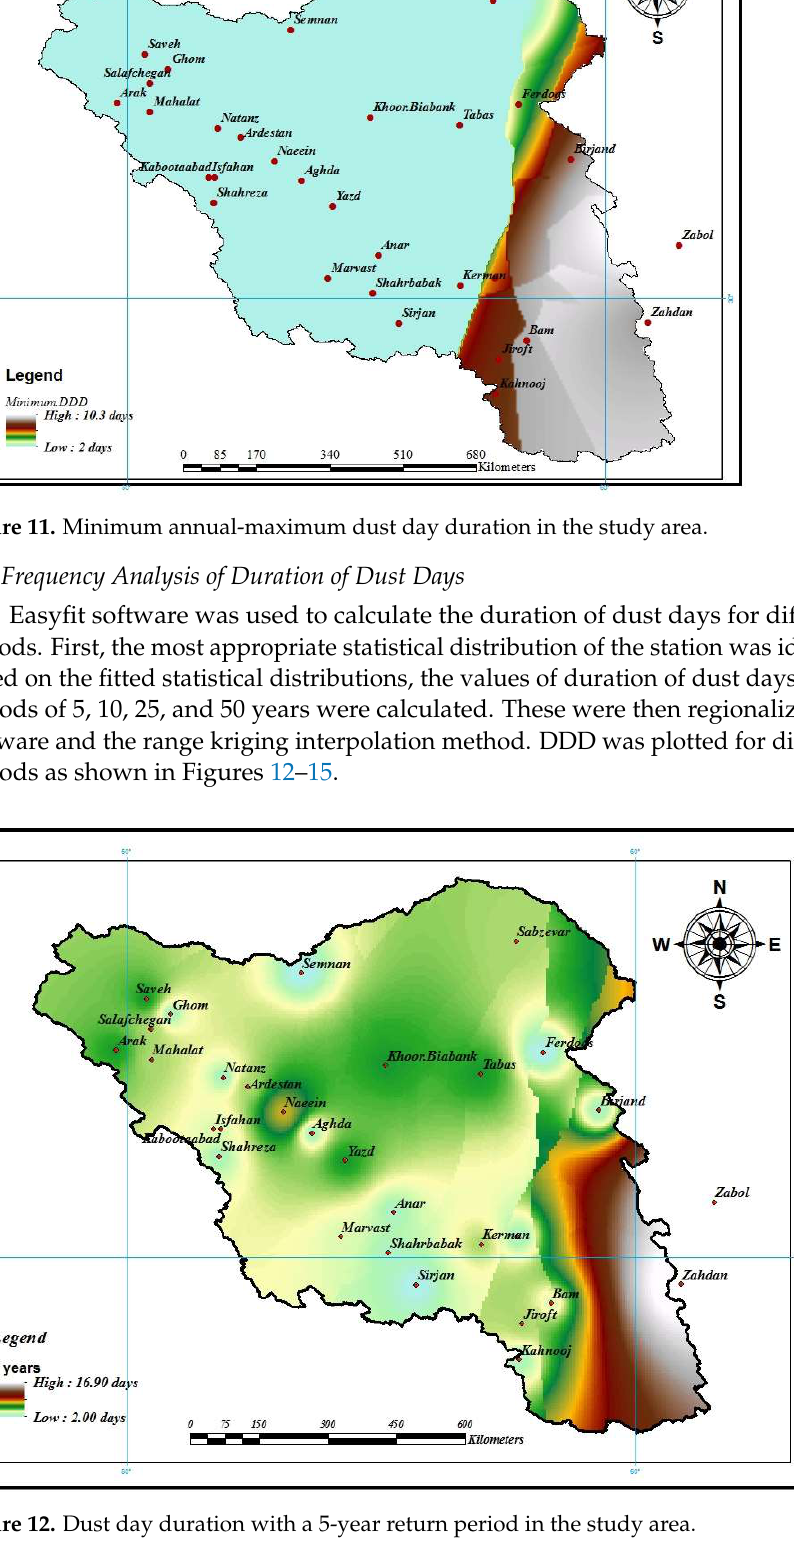
Figure 13. Dust day duration in the 10-year return period in the study area.